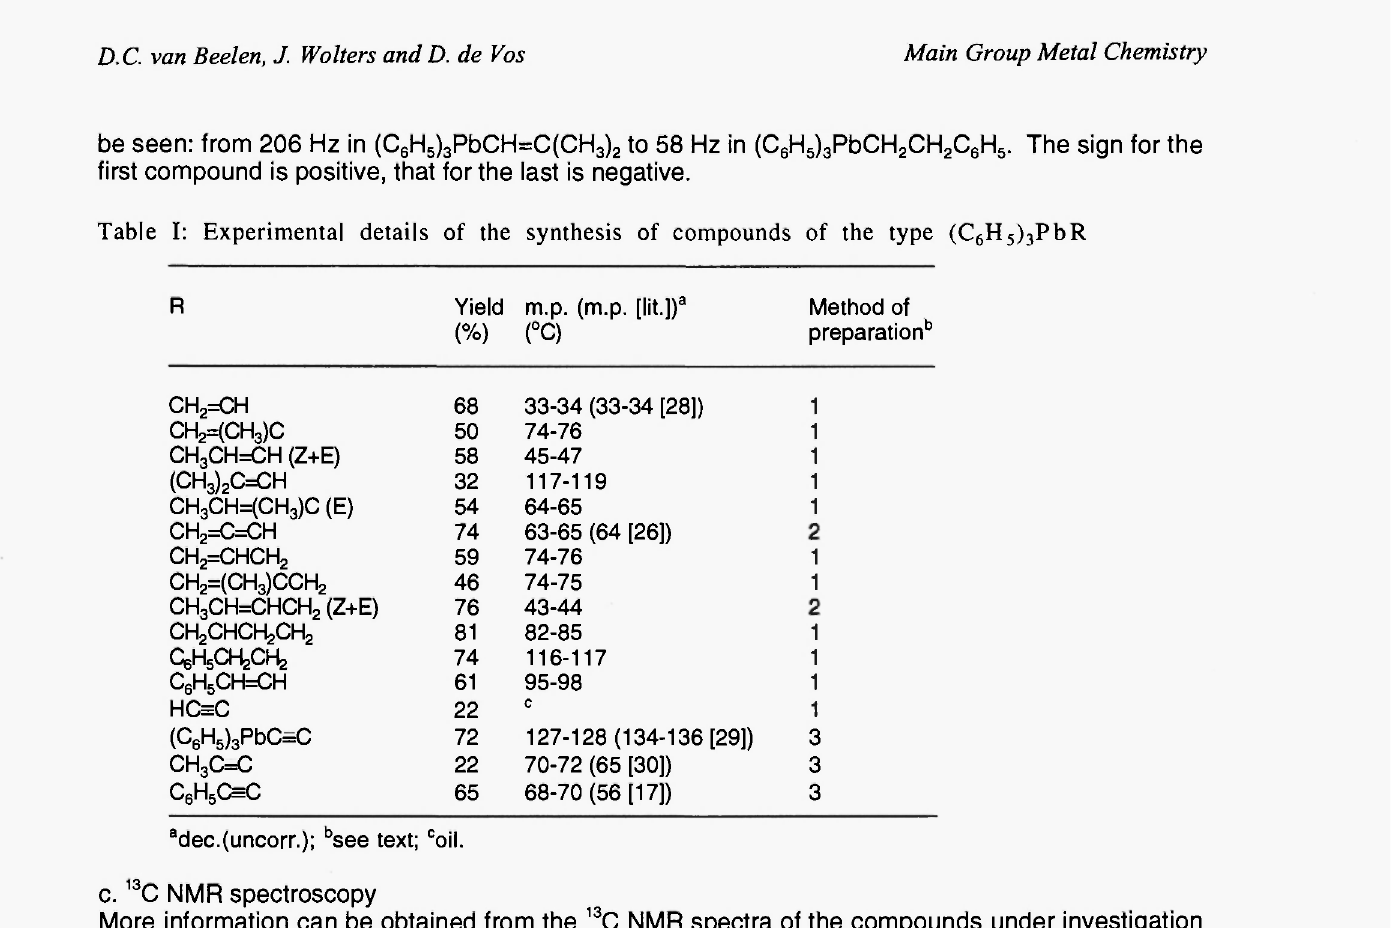
Table I: Experimental details of the synthesis of compounds of the type (C 6 H 5 ) 3 PbR